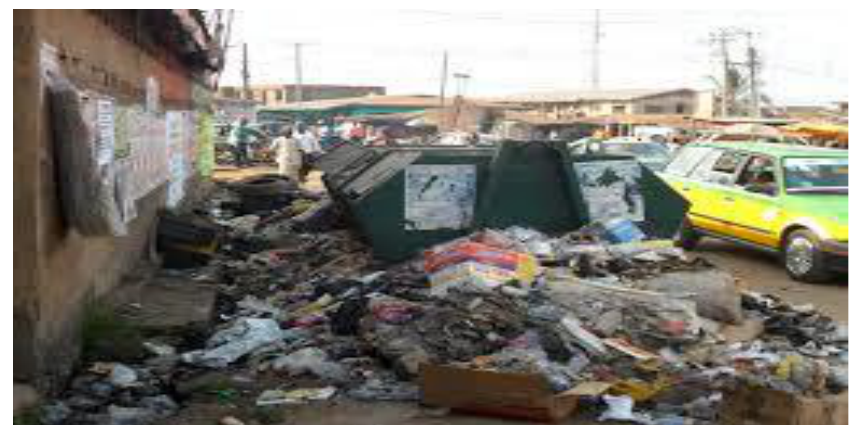
Fig. 2 : An overflowing bulk storage container in the street of Ilorin